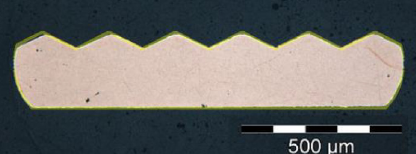
Fig. 5. Typical geometry of an LCR and its approximation for numerical simulations.